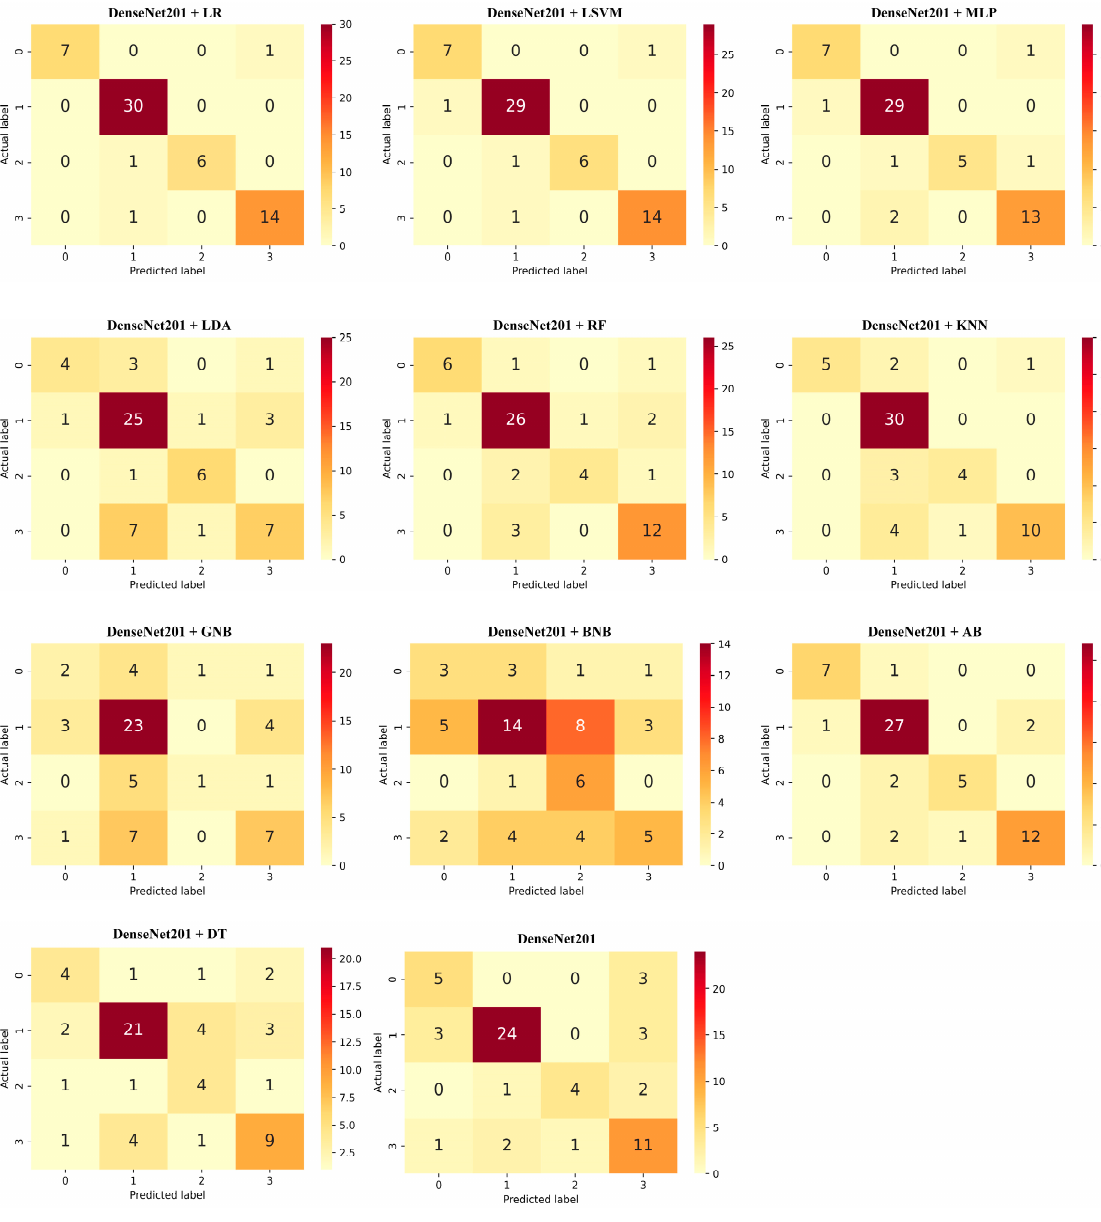
Figure 6. Confusion matrices of hybrid machine learning algorithms. Table 5. Classification reports of algorithms making the highest numbers of predictions based on the confusion matrix.